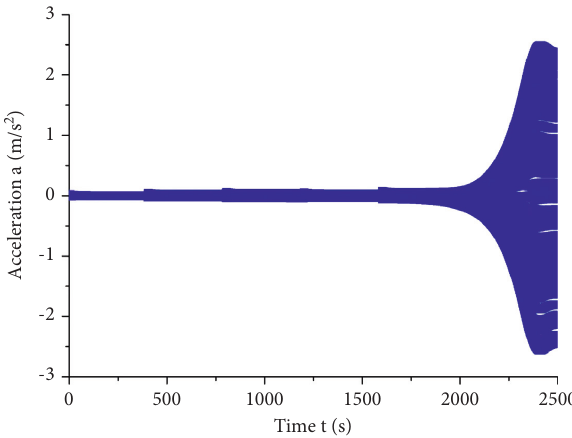
Figure 17: Time history curve of mid-span